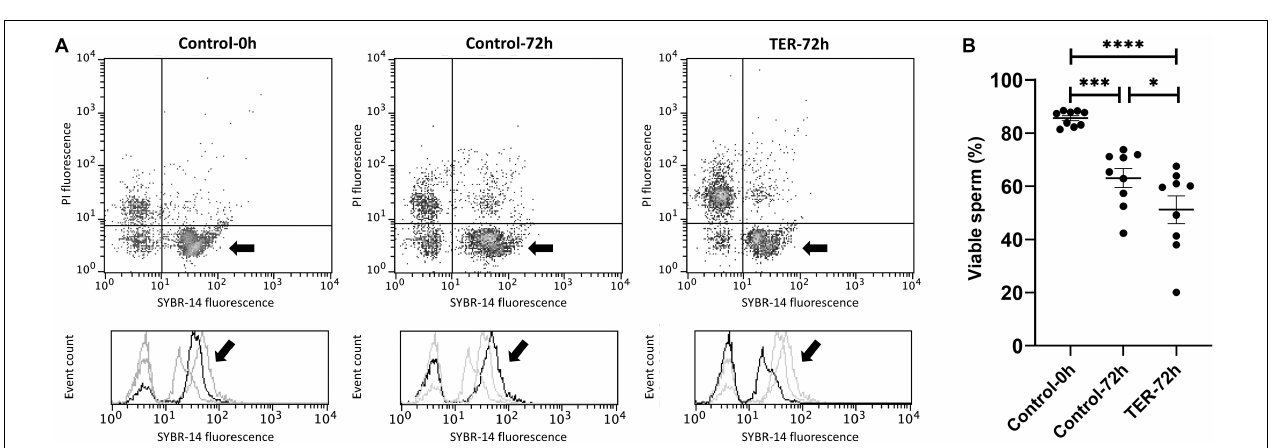
FIGURE 4 | Flow cytometry analysis of sperm viability. (A) Representative flow cytometry dot plots of propidium iodide (PI) and SYBR-14 fluorescence and histograms showing the event count of SYBR-14 fluorescence intensity of all treatments. Black arrows show the flow cytometry population selected for analysis represented in (B) . Dark gray lines in histograms show the event count of its corresponding treatment, whereas light gray lines show the event count of the remaining treatments. (B) Mean, standard error of the mean (SEM), and sample distribution of the percentage of viable sperm in all treatments. Control-0h, semen samples at 0 h of storage; Control-72h, vehicle control (dimethyl sulfoxide; DMSO) semen samples at 72 h of storage at 17 ◦ C; TER-72h, semen samples treated with 100 µ M ezatiostat (TER) for 72 h of storage at 17 ◦ C. Sample size ( n = 9). * p ≤ 0.05; *** p ≤ 0.001; **** p ≤